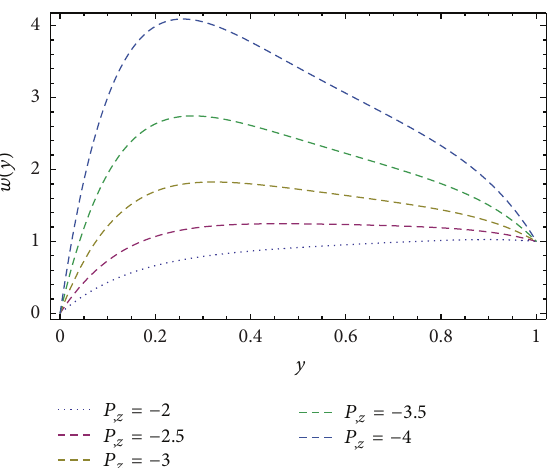
Figure 6: Profile of the nondimensional velocity 𝑢(𝑦) for different ̃𝛽 = 0.3 , 𝑃 ,𝑥 = −2.0 , and 𝜙 = 45 ∘ . values of 𝑃 ,𝑧 , keeping